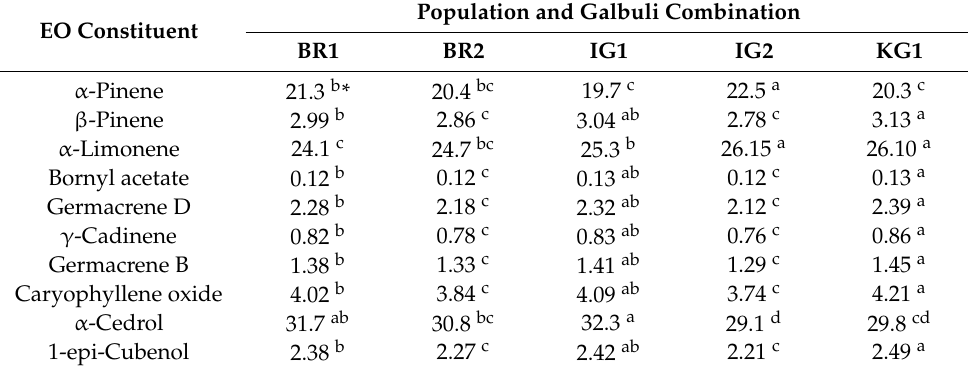
Table 3. Mean concentrations of α -pinene, β -pinene α -limonene, bornyl acetate, germacrene D, γ -cadinene, germacrene B, caryophyllene oxide, α -cedrol and 1-epi-cubenol obtained from Bachkovo in the Rhodope Mountains without galbuli (BR1), Bachkovo in the Rhodope Mountains with galbuli (BR2), Izgoryaloto Gyune in the Rhodope Mountains with galbuli (IG1), Izgoryaloto Gyune in the Rhodope Mountains without galbuli (IG2), and Kresna Gorge (spread out at the the Pirin and Maleshevska Mountains) with galbuli (KG1) of Juniperus excelsa in Bulgaria. Population and Galbuli Combination EO Constituent BR1 BR2 IG1 IG2 KG1 α -Pinene 21.3 b * 20.4 bc 19.7 c 22.5 a 20.3 c β -Pinene 2.99 b 2.86 c 3.04 ab 2.78 c α -Limonene 24.1 c 24.7 bc 26.10 a Bornyl acetate 0.12 b 0.12 c 0.13 ab Germacrene D γ -Cadinene 0.82 b 0.78 c 0.83 ab Germacrene B Caryophyllene oxide 4.02 b α -Cedrol